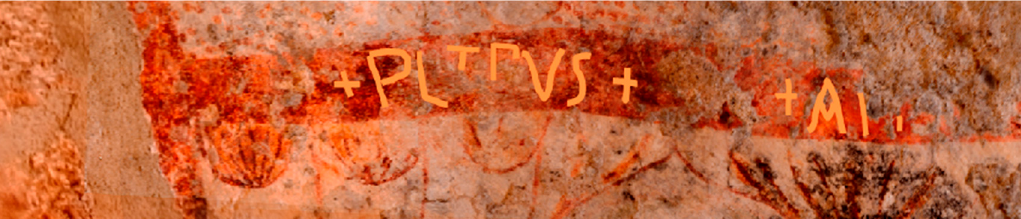
Figure 11. Sant Miquel de Terrassa, wall paintings. Epigraphic inscription: PETRVS. © Jordi López and Diana Gorostidi (with kind permission).